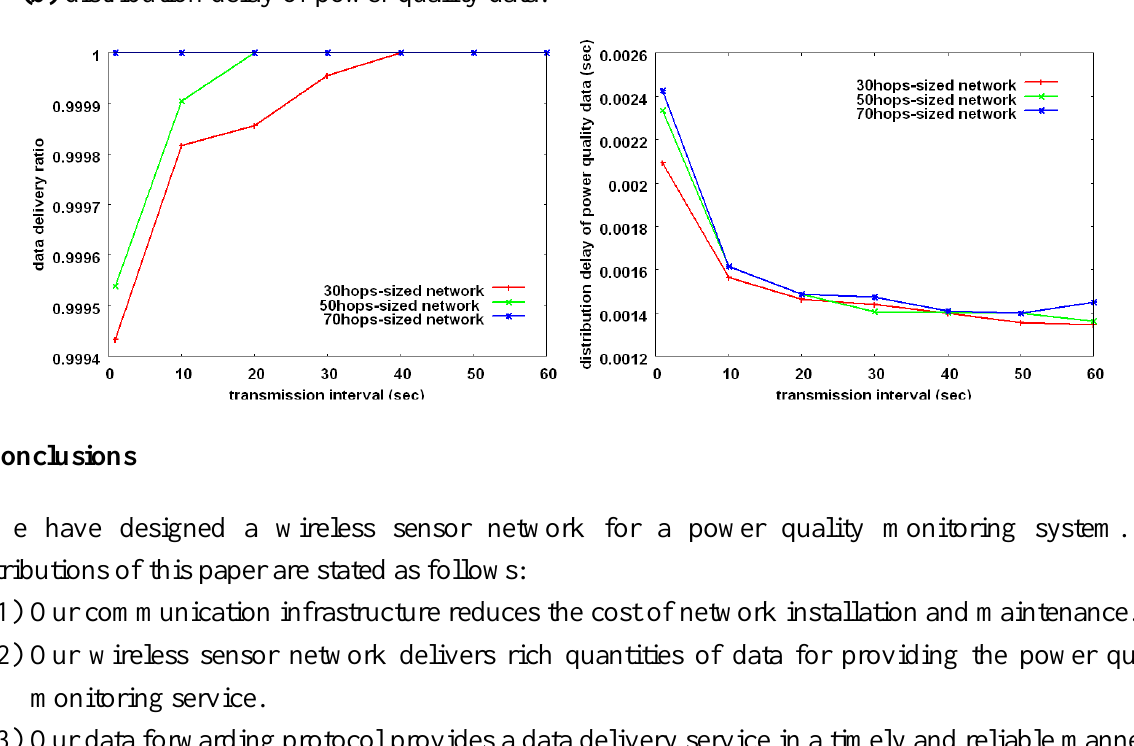
Figure 8. Performance in environment around the substation. (a) data delivery ratio (b) distribution delay of power quality